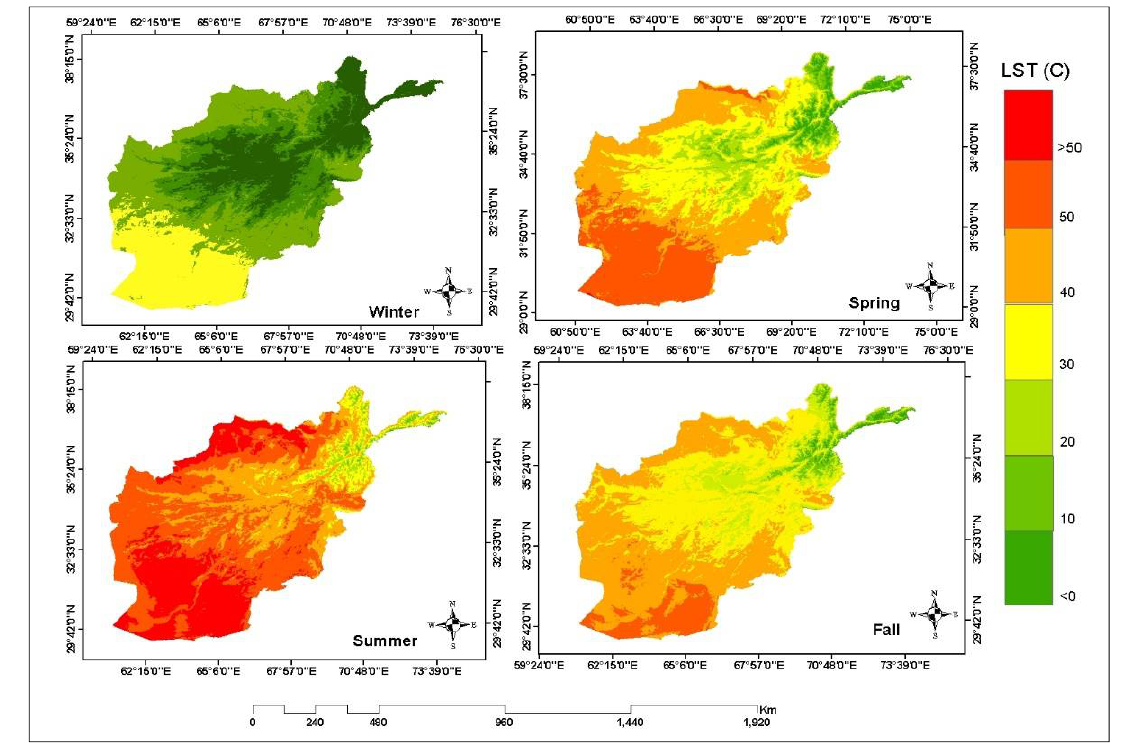
Figure 6. The maps of the seasonal mean LST in Afghanistan in the period 2000–2021.